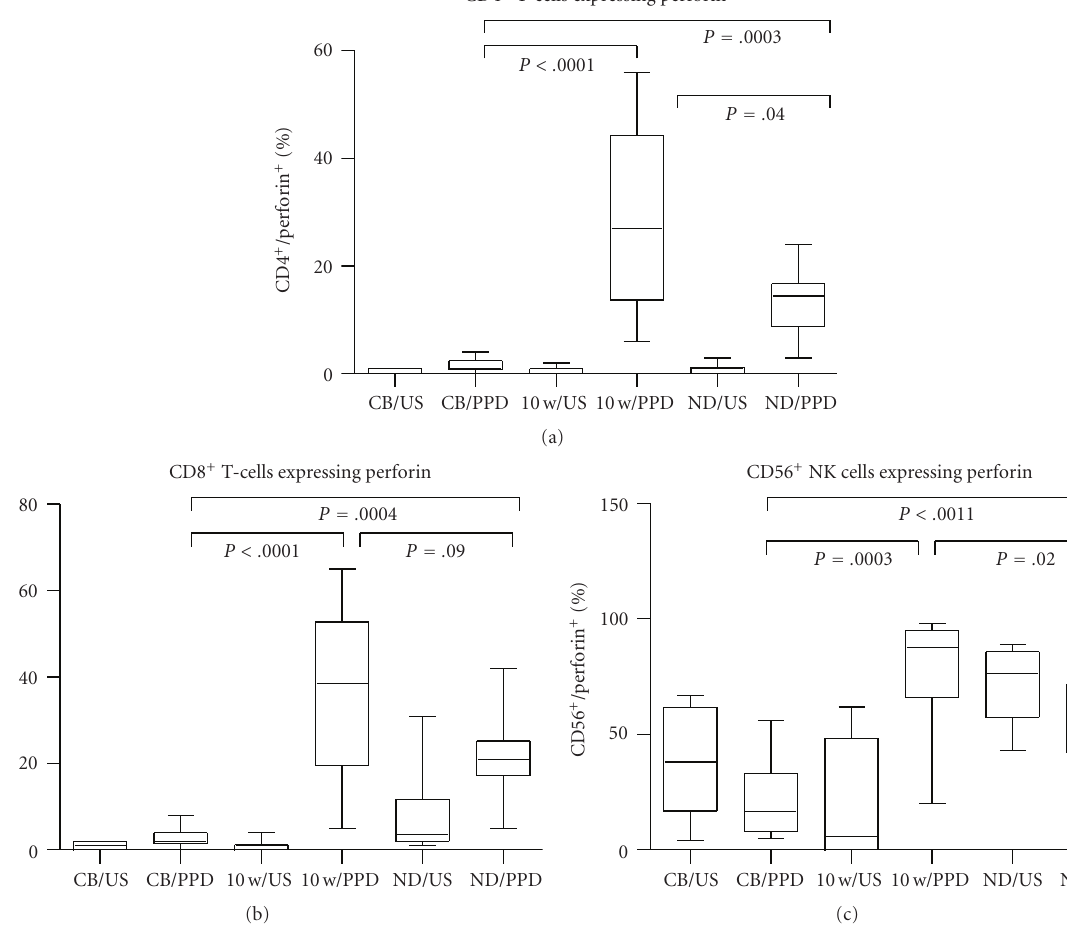
Figure 3: Perforin expression in CD4 + (a) and CD8 + (b) T-cells and CD56 + (c) NK cells in unstimulated (US) and PPD-stimulated mononuclear cells isolated from cord blood (CB, n = 10) or peripheral blood from BCG-vaccinated infants (10w, n = 45) or healthy PPD + adult volunteers (ND, n = 10). Significance is shown as PPD stimulation in CB compared to 10-week-old infants and healthy adult controls, and 10-week-old compared to healthy adult controls. The box extends from the 25th to 75th percentile, the line represents the median, and the whiskers represent the maximum and minimum